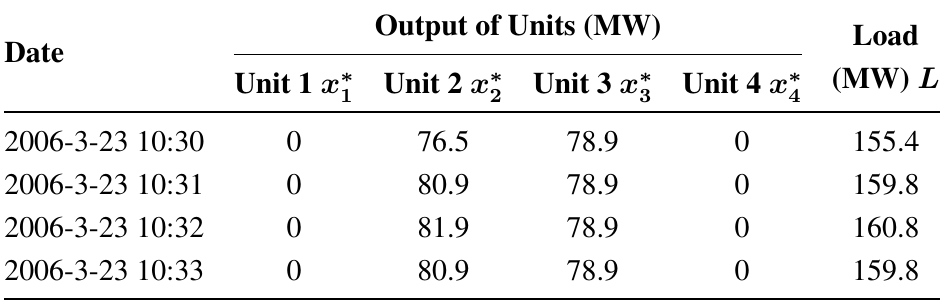
Table 3. The load distribution of units in practical